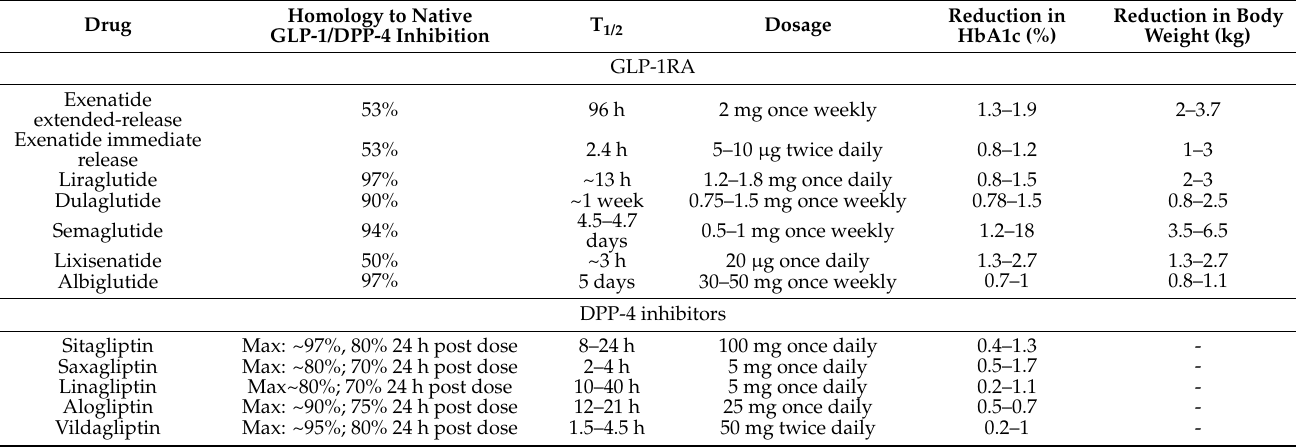
Table 2. Incretin-based therapies approved for T2DM [18,221,229,230].